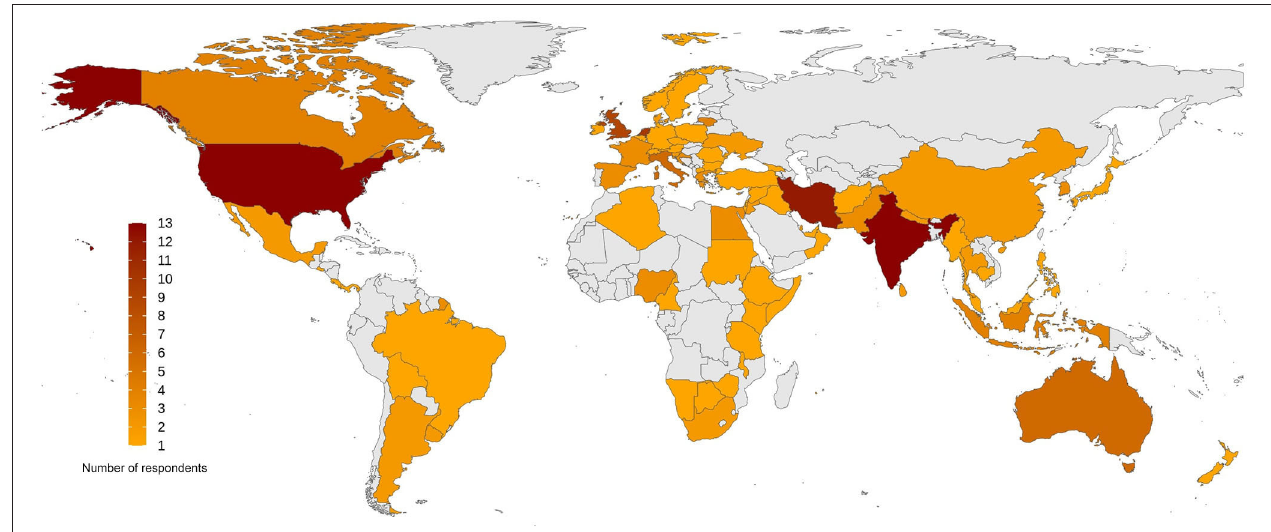
FIGURE 1 | Global distribution of the respondents to the survey. The survey involves 177 respondents from 77 countries around the world, ranging from 1 to 13 participants from each country, demonstrated as a color spectrum from orange to dark red.